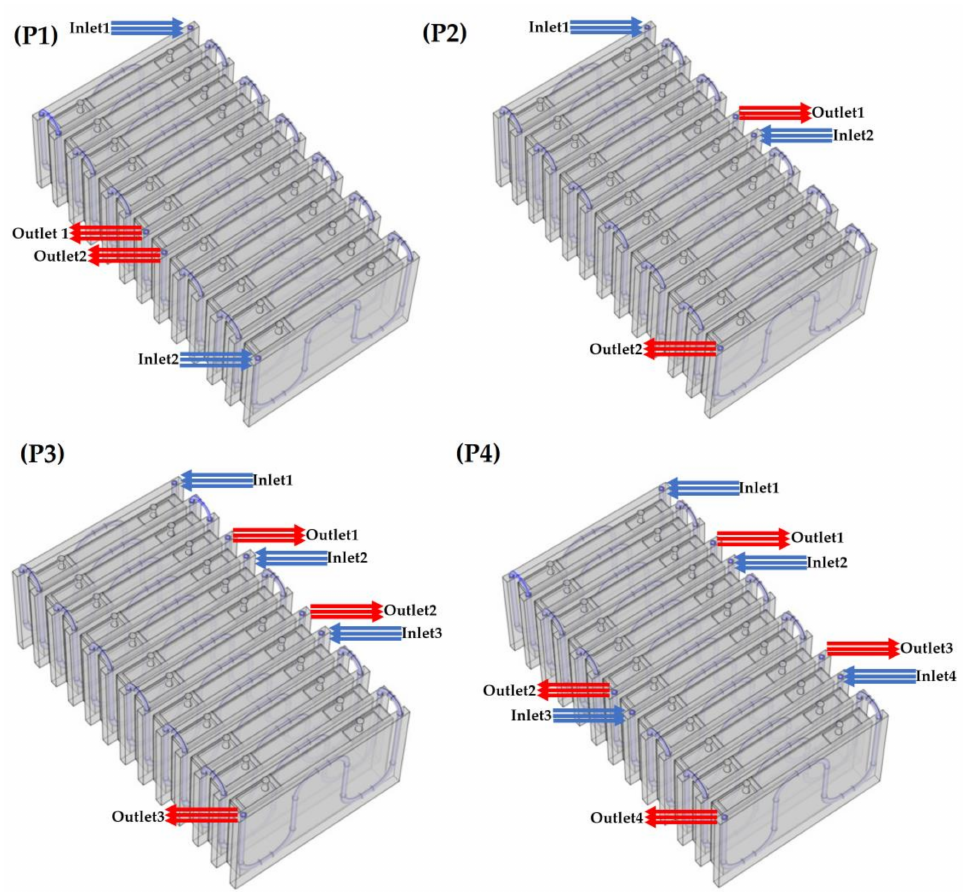
Figure 16. The proposed schematic of different inlet and outlet